Question: Which visualization type does this figure use?
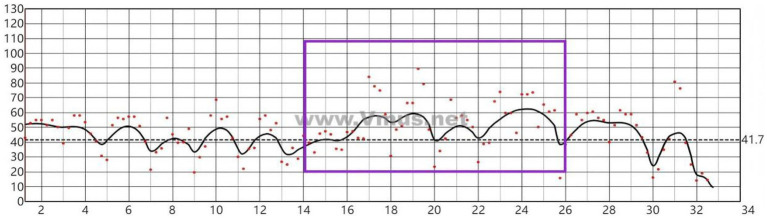
Answer: line